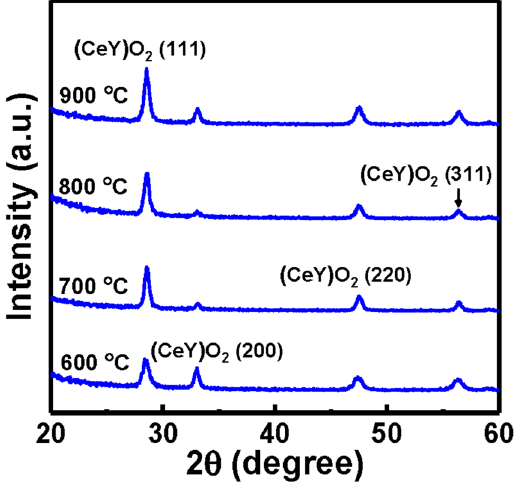
Figure 2. XRD patterns of CeY x O y films that had been annealed at various